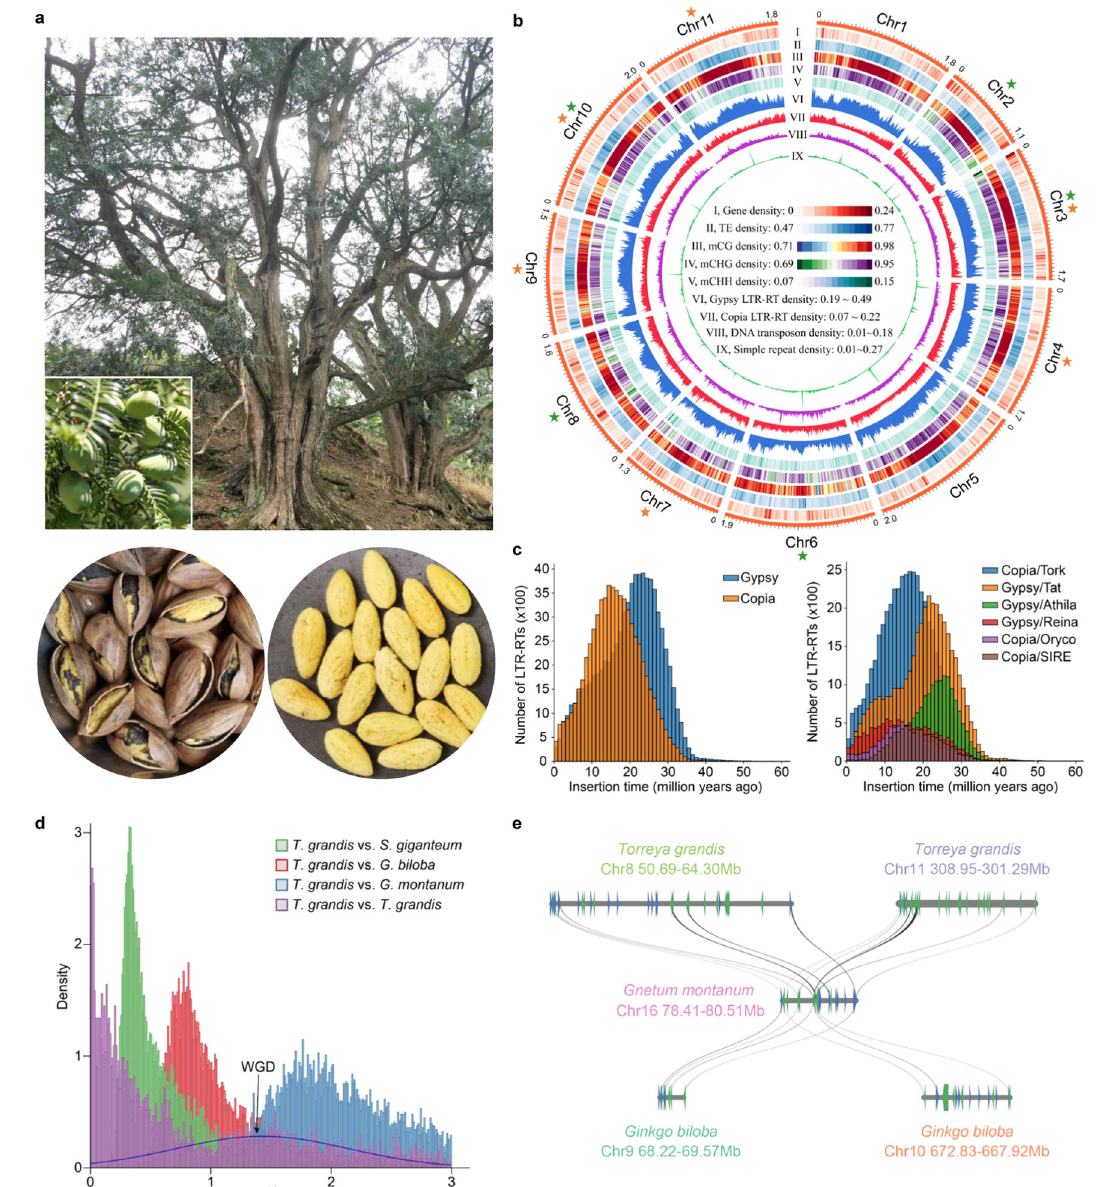
Fig. 1 | Genome of T. grandis . a Tree and fruit set of T . grandis . The lower panel shows the processed dry seed and its edible part (endosperm). b Circos plot of T. grandis genomeandgenomicfeaturesencodedbythechromosomes.Eachfeature was calculated based on a 10-Mb window across the chromosomes. Colored stars indicatethepresenceoftelomericsequenceson5 ’ -(green)or3 ’ -end(orange)ofthe chromosome. c Distribution of LTR-RT insertion time. The left panel shows all